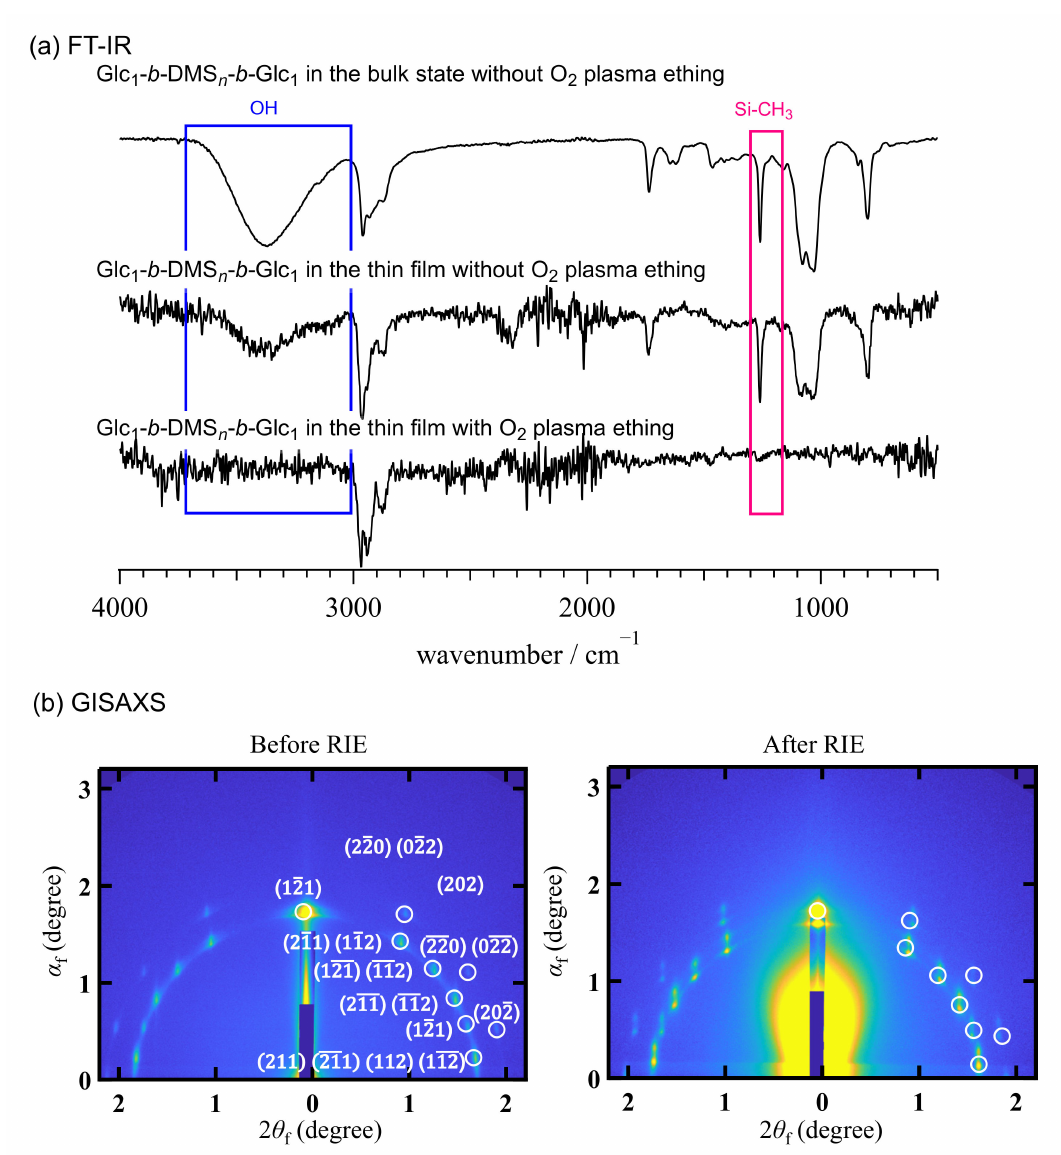
Figure 4. ( a ) ATR FT-IR spectra of Glc 1 - b -DMS n - b -Glc 1 measured in the bulk state ( upper ) and measured in the thin film state before ( middle ) and after the RIE ( lower ); ( b ) GISAXS images of Glc 1 - b -DMS n - b -Glc 1 before ( left ) and after the RIE ( right